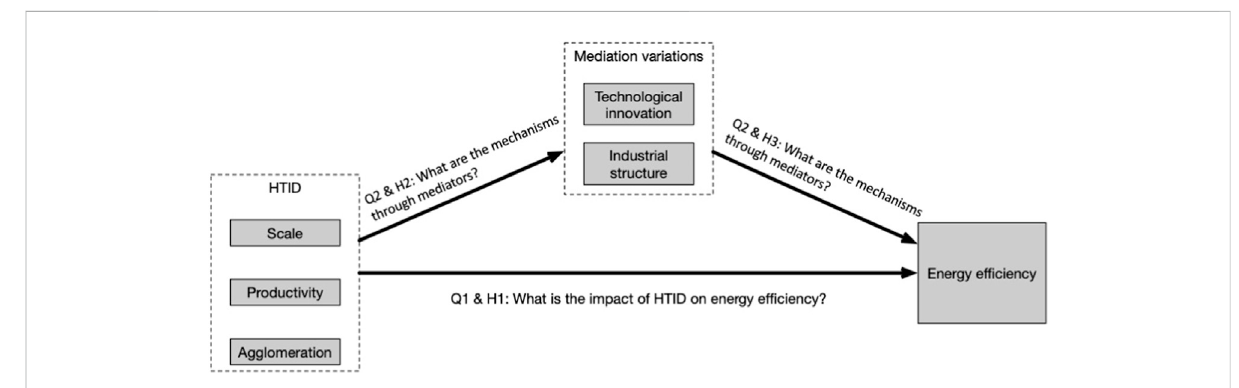
FIGURE 2 The research conceptualized